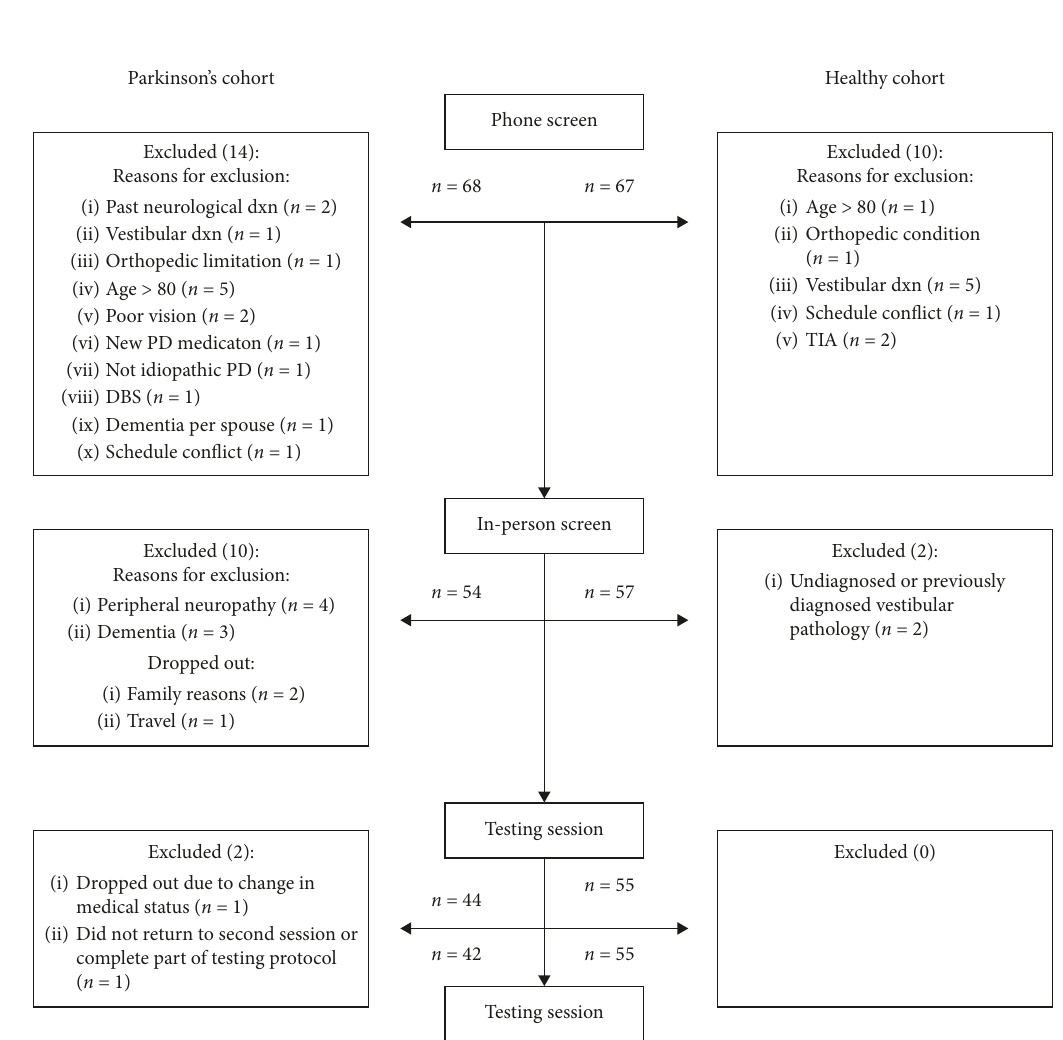
Figure 1: Participant flow